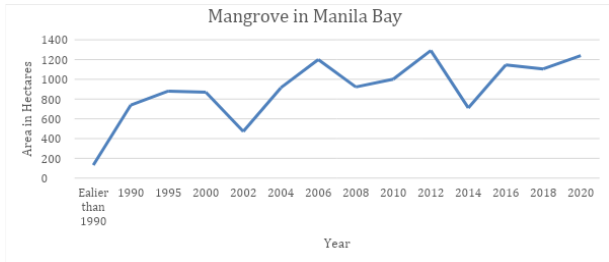
Figure 11. Area of mangroves in Manila Bay per